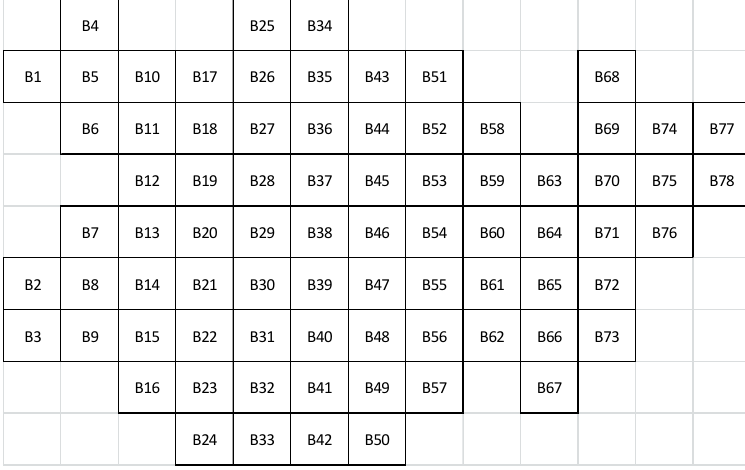
Figure 4. Block model of a coal deposit.